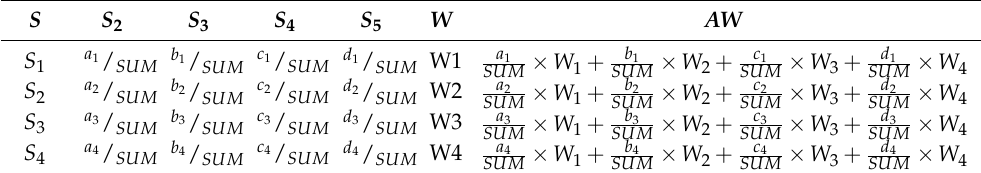
Calculate the maximum eigenvalue of the judgment matrix ( λ max ).